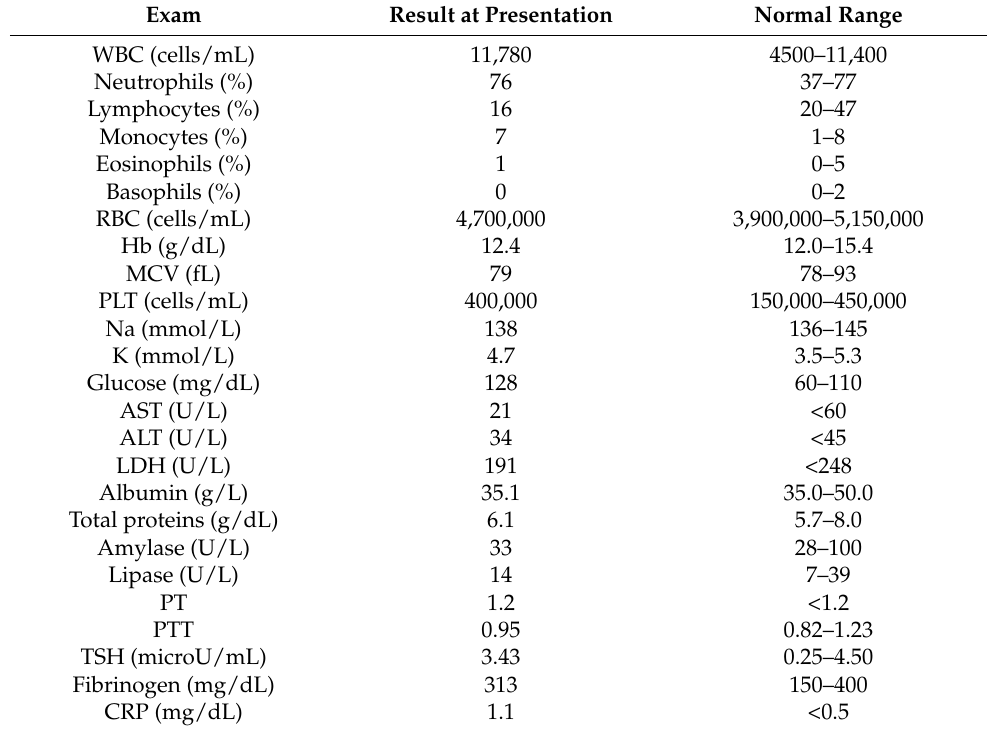
Table 1. Laboratory findings. WBC: white blood cells; RBC: red blood cells; Hb: hemoglobin; MCV: mean corpuscular volume; PLT: platelets; Na: sodium; K: potassium; AST: